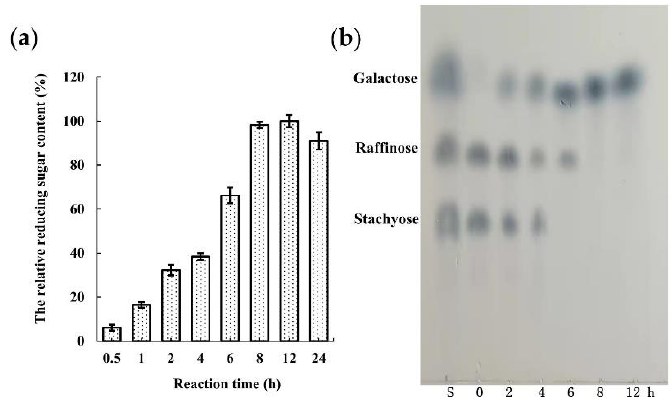
Figure 7. ( a ): The released reducing sugar content from RFOs after treatment with ORG; ( b ): TLC analysis of hydrolysis products of raffinose family oligosaccharides (RFOs) after treatment with ORG. Lane S, a mixture of galactose, raffinose and stachyose. Control (0 h) indicates without ORG treatment.